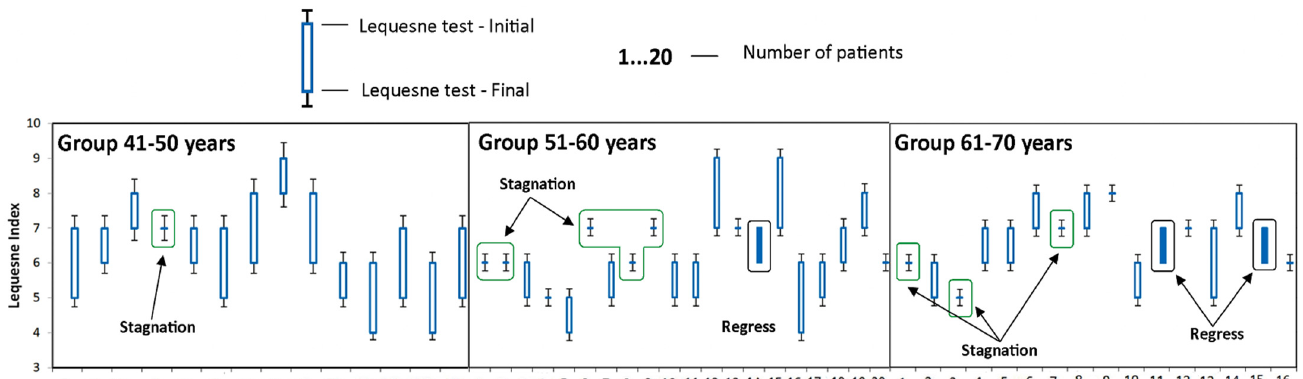
Figure 2. Evolution of body mass index (BMI) during the study at the group A. Stagnation—the value of the parameter obtained at time T1 is the same as the value of the parameter obtained at time T0; Regress—the parameter obtained at time T1 is less than the value of the parameter obtained at time T0.